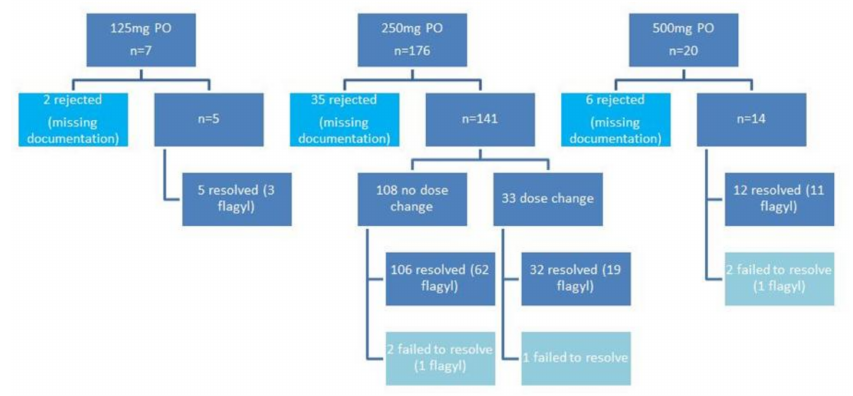
Figure 1. Patient